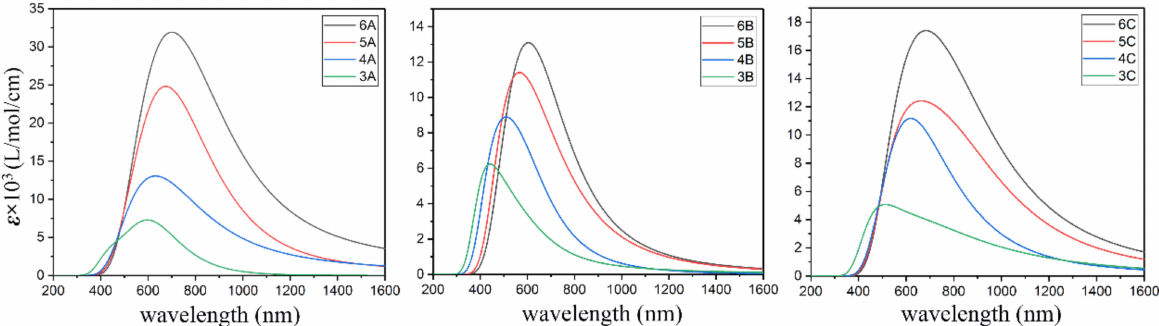
Figure 3. Electronic absorption spectra with full width at half maximum (FWHM) 0.26 of A , B , and C